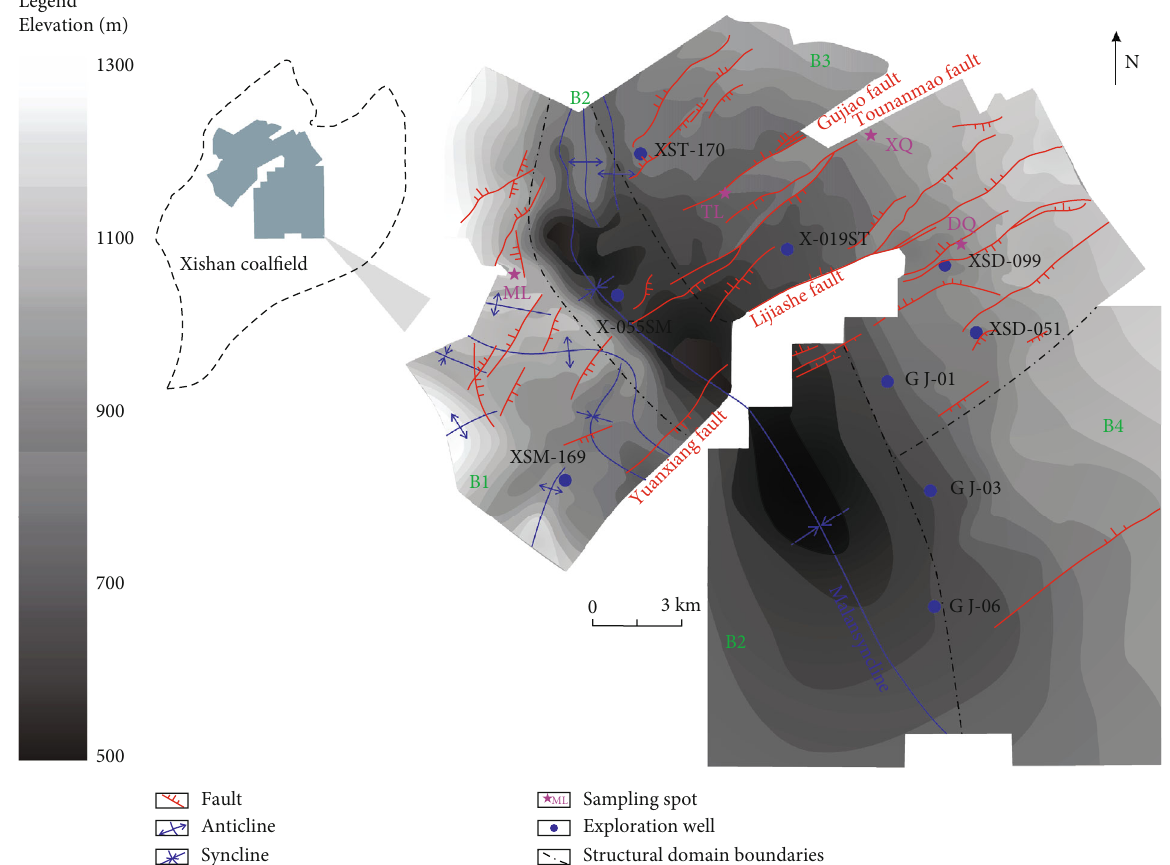
Figure 2: Geological structure and elevation of the No. 8 coal seam in Gujiao CBM fi eld. B1 – B4 are structural